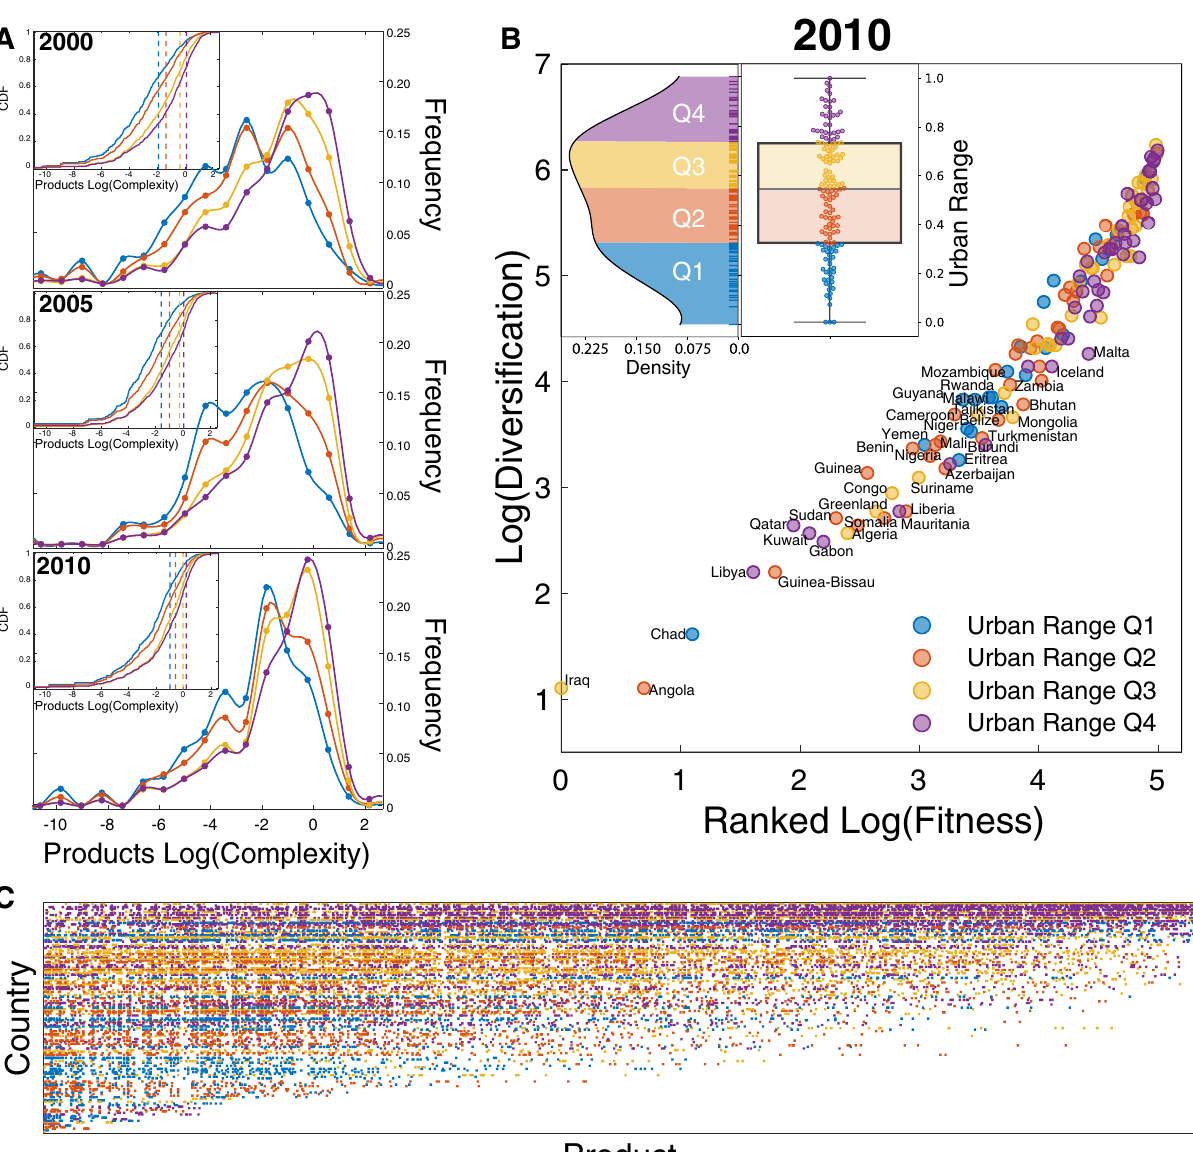
Figure 1. ( A ) Distribution of exported products complexity by different urbanization levels through the 2000–2010. There is a shift of lower urbanized countries towards the export of more complex products ( B ) Distribution of the Urban Range (percentage of the total population living in urban areas) of the 144 countries analyzed. ( B ) Ranked country fitness versus products export diversification, the highly diversified countries are one’s with more fitness and high urbanization, meanwhile low urbanized country are in the center bottom of the scatter plot, with some exceptions such as those with links to the oil countries. ( C ) Matrix of the country exports in 2010, reordering the countries and products by fitness and complexity; the color dots represent an exported product under the RCA threshold Eq. (2), the color gradient follows the urban range